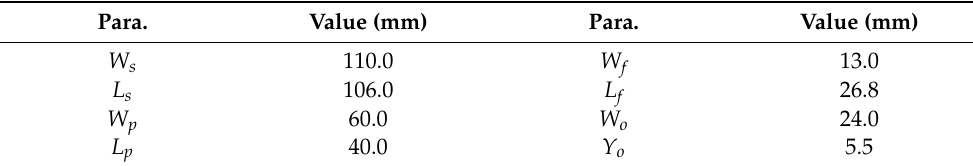
Table 1 lists the optimized dimensions of the patch antenna. Table 1. Parameters dimensions of the proposed antenna with RIS. Table 1. Parameters dimensions of the proposed antenna with RIS. Para. Para.